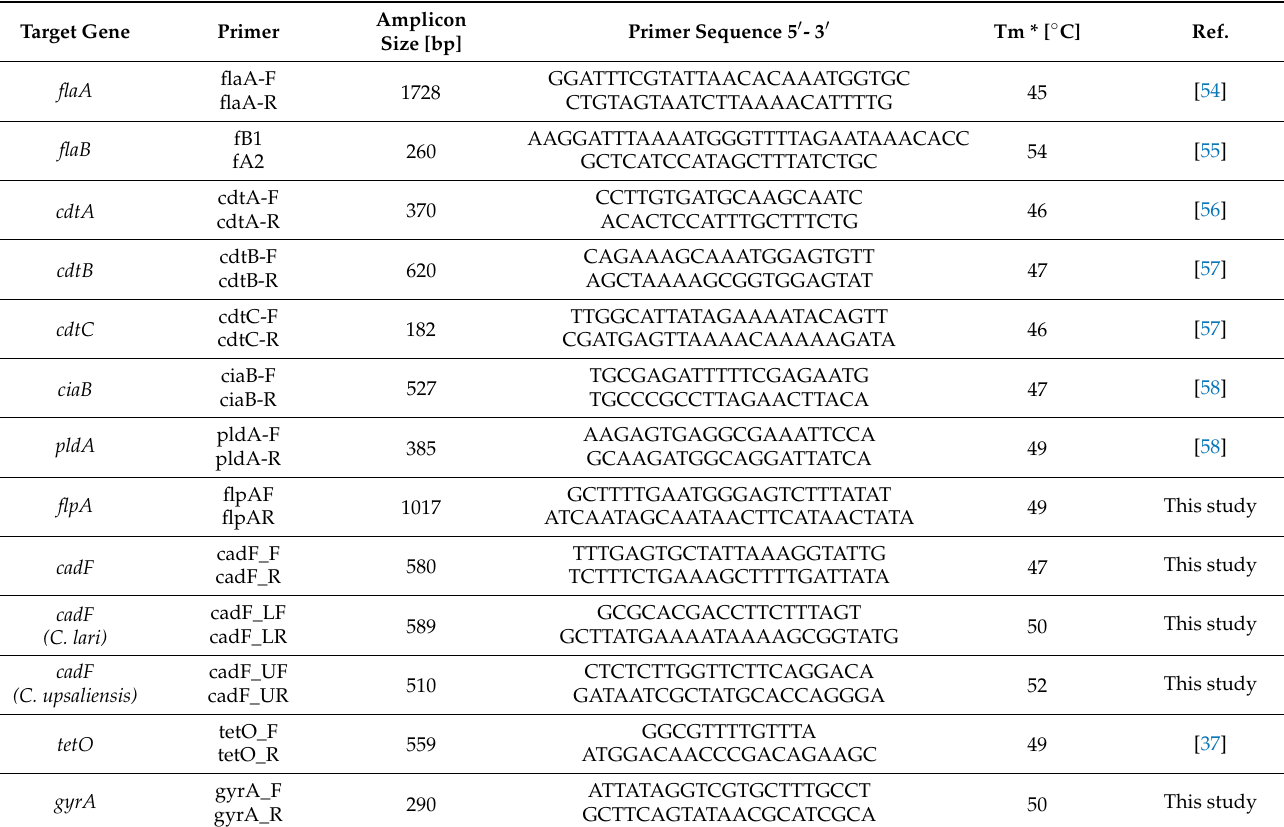
Table 3. Primers used in this study for the detection of virulence factor genes and determination of the molecular mechanisms of antimicrobial